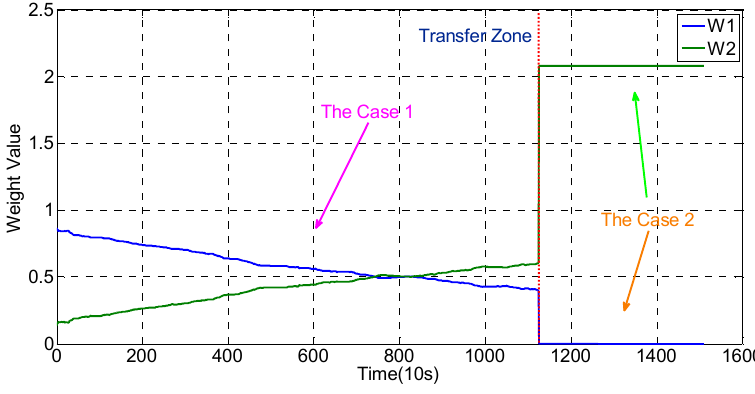
Figure 14. The variation of weighed coefficients.